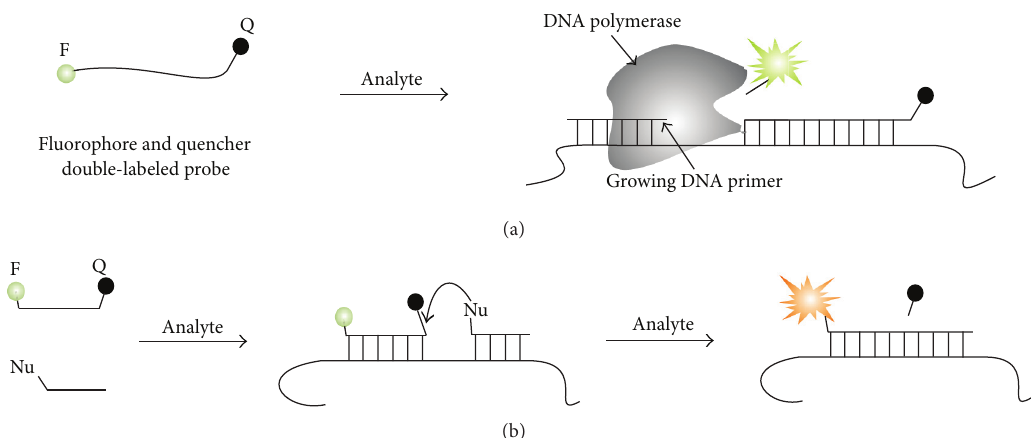
F 2: �xamples of �uorescent reporters. (a) TaqMan probe. Fluorophore- and quencher-labeled stem-free oligonucleotide hybridizes to a single-stranded DNA amplicon and becomes cleaved by the 5 [16–18].(b)Chemicalautoligationassay[18–20].Anoligonucleotidewitha�uorophoreandaquencherhybridizestotheanalyteinproximity to the second oligonucleotide probe equipped with a nucleophilic reactive group. Chemical reaction of the two oligonucleotide probes